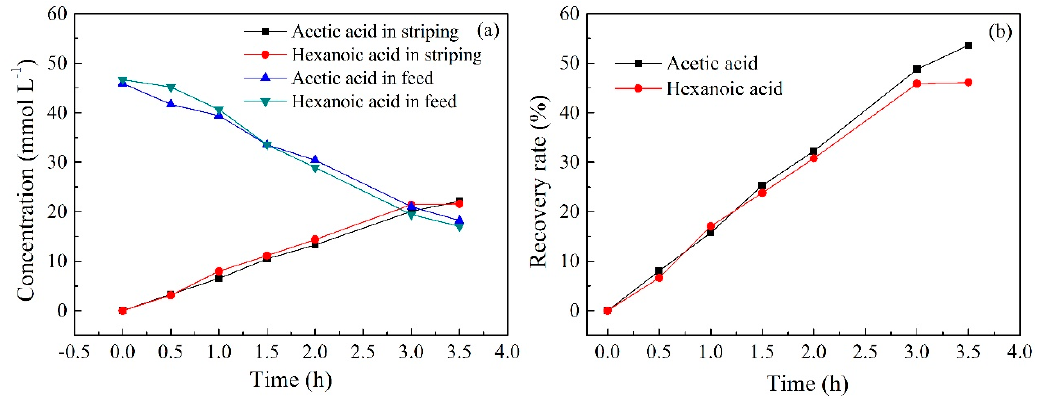
Figure 13. ( a ) The changes of acid concentration in the feed and stripping solution and ( b ) the recovery rate of both acids during electrodialysis (PIMs: PIM4; Feed solution: 0.05 mol L − 1 acetic acid +0.05 mol L − 1 hexanoic acid, pH = 6; Stripping solution: 0.1 mol L − 1 HCl; Current density: 5 mA cm − 2